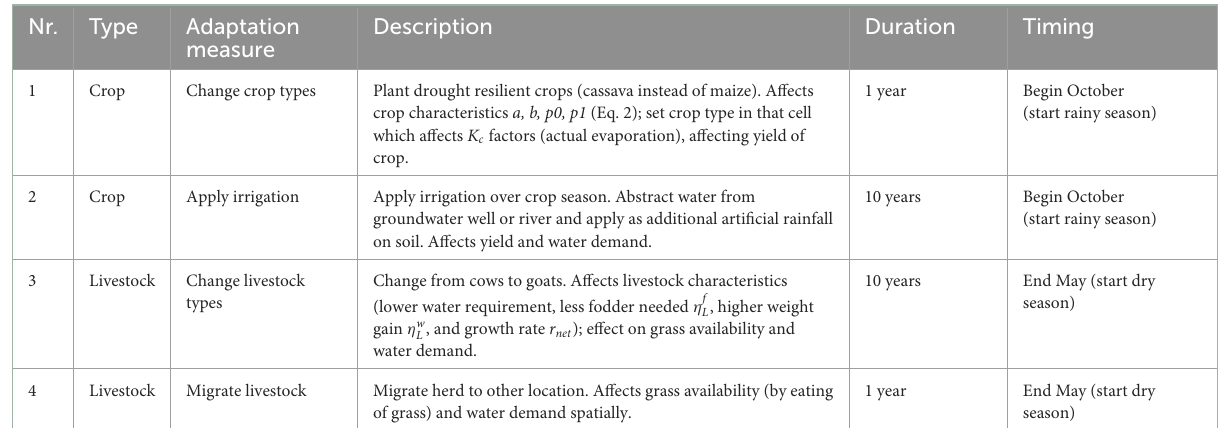
TABLE 1 Adaptation measure description, effect on environment and decision timing.